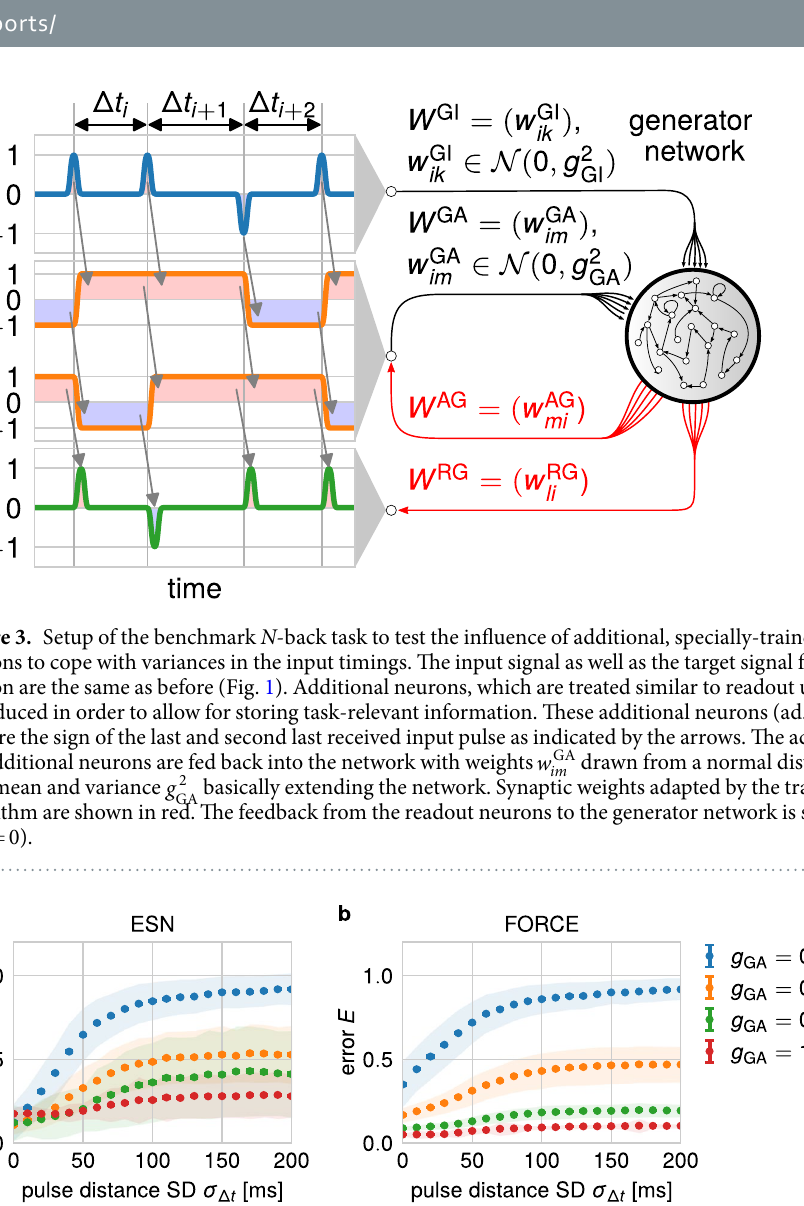
input stimuli by varying the standard deviation σ Δ t of the interstimulus intervals Δ t while keeping the mean μ Δ t constant. For each value of the standard deviation, we average the performance over 1000 different (random) network instantiations. Overall, independent of the training method (ESN as well as FORCE) used for the readout weights, the averaged error 〈 E 〉 increases significantly with increasing values of σ Δ t until it converges to its theo- retical maximum at 1 at about σ Δ t ≈ 100 ms (Fig. 2). Note that errors larger than 1 are artifacts of the used training method. The increase of the error (or decrease of the performance) with larger variances in the stimuli timings is independent of the parameters of the reservoir network. For instance, we tested the influence of different values 2 of the feedback weight matrix W GR from the readout neurons to the generator network (Fig. 2a of the variance g GR for ESN and b for FORCE). For the present N -back task, feedback of this kind does not improve the performance, although several theoretical studies show 33–35 that feedback enhances the performance of reservoir networks in other tasks. In contrast, we find that increasing the number of generator neurons N G reduces the error for a broad regime of the standard deviation σ Δ t (Fig. 2c and d). Nevertheless, the qualitative relationship is unchanged and the improvement is weak implying a need for large numbers of neurons to solve this rather simple task for medium values of the standard deviation. Another relevant parameter of reservoir networks is the standard devi- ation g GG of the distribution of the synaptic weights within the generator network determining the spectral radius of the weight matrix 25 . In general, the spectral radius determines whether the network operates in a sub-critical,